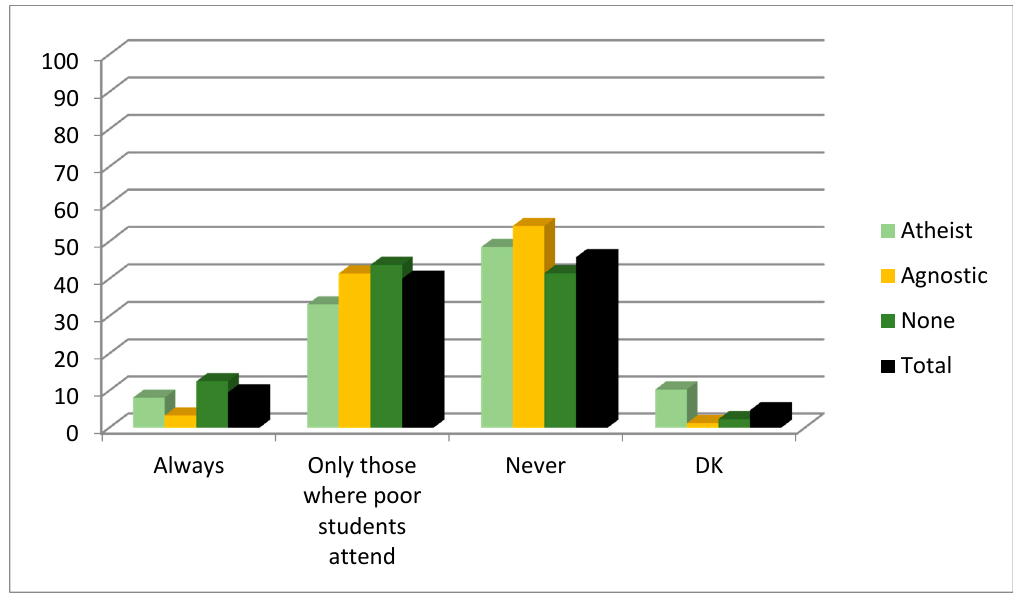
Figure 11. Opinion on public funding for religious schools (in %). Based on 382 cases. Source: Author’s elaboration based on the Second National Survey on Religious Beliefs and Attitudes. Society, Culture and Religion Program, CEIL-CONICET, 2019.